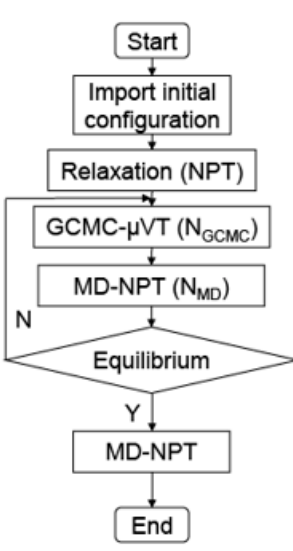
Figure 2. Flow chart of hybrid GCMC/MD simulation.